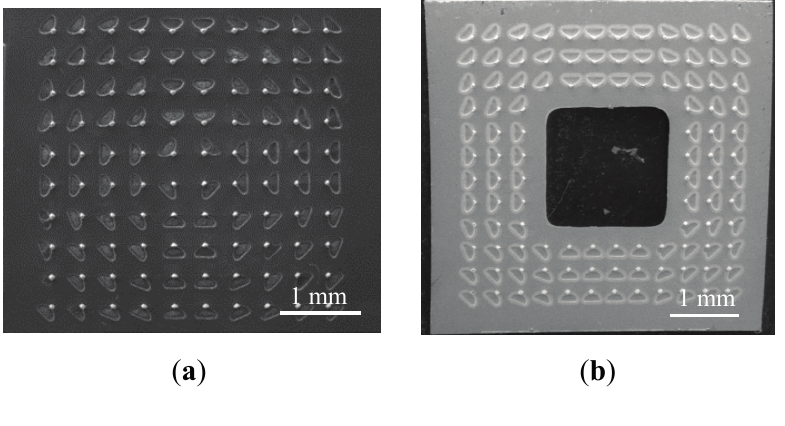
Figure 8. Tip array SEM images: ( a ) without TSV; ( b ) with TSV at the array center; and ( c ) with TSV beside the array. The scale bar is 1